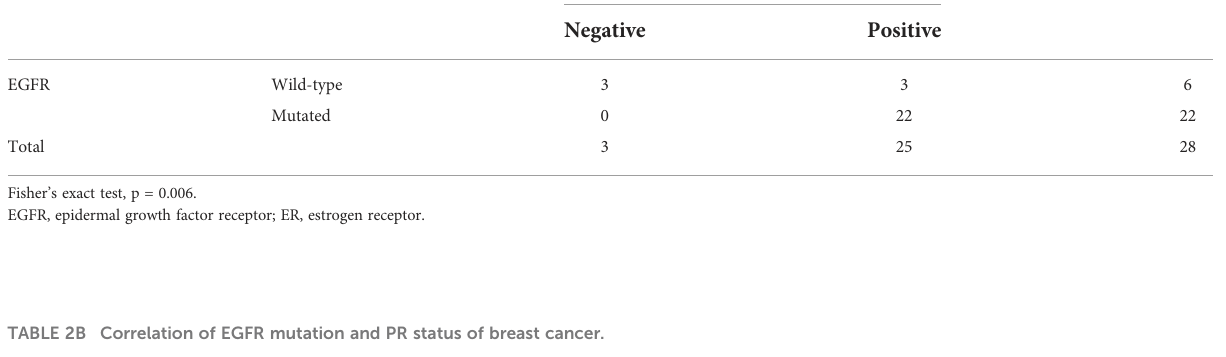
TABLE 2A Correlation of EGFR mutation of lung cancer and ER status of breast cancer. No. ER Total Negative Positive